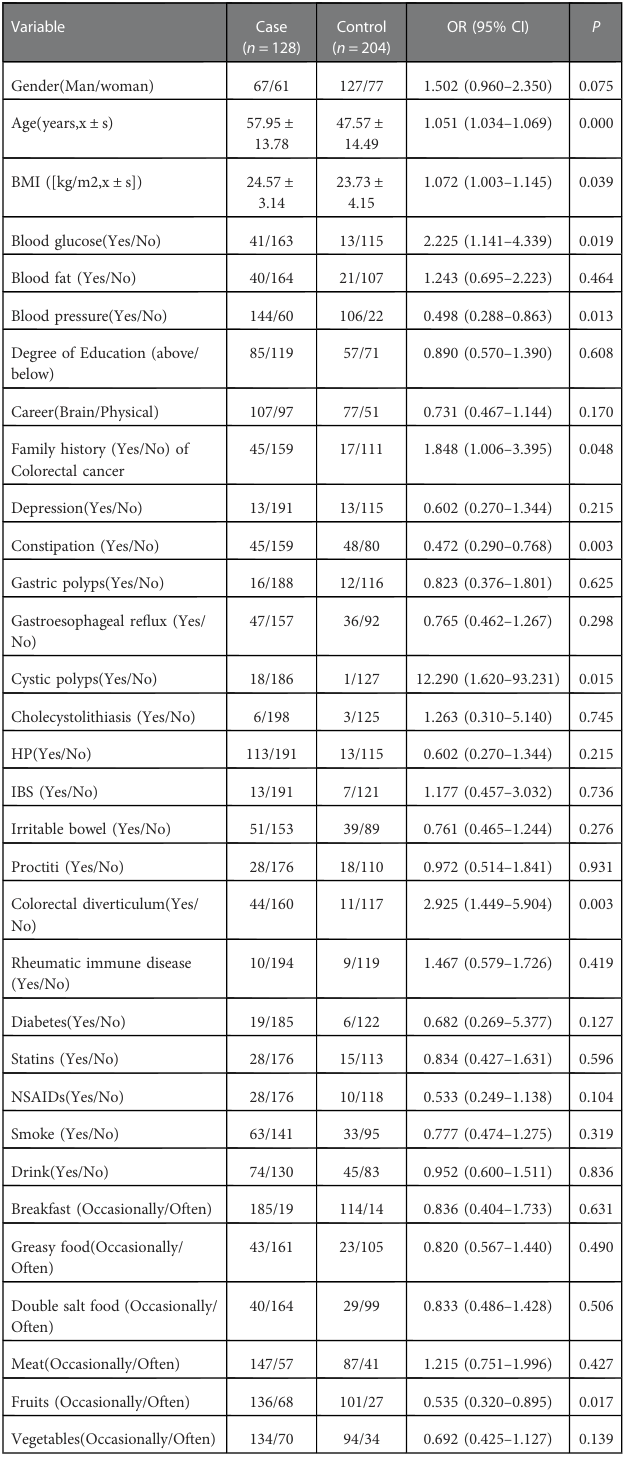
TABLE 2 Single-factor logistic regression analysis based on training set. TABLE 3 Multivariate analysis based on training